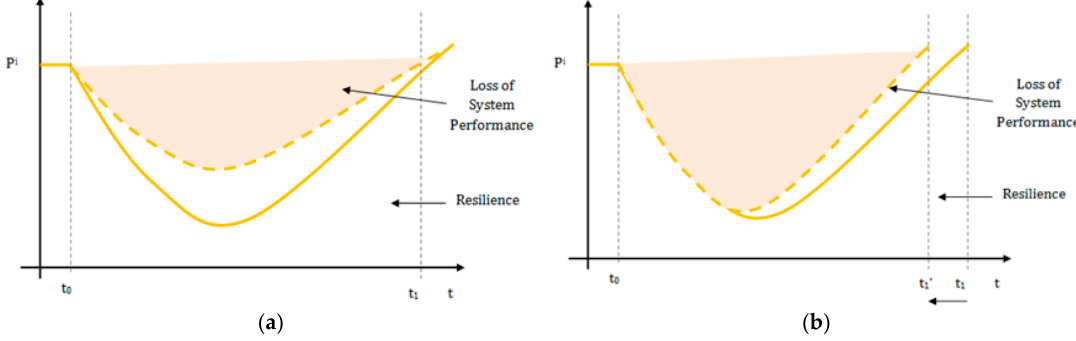
Figure 9. ( a ) Impact of a proactive adaptation option on the value of resilience; and ( b ) the impact of reactive adaptation option on the value of resilience.